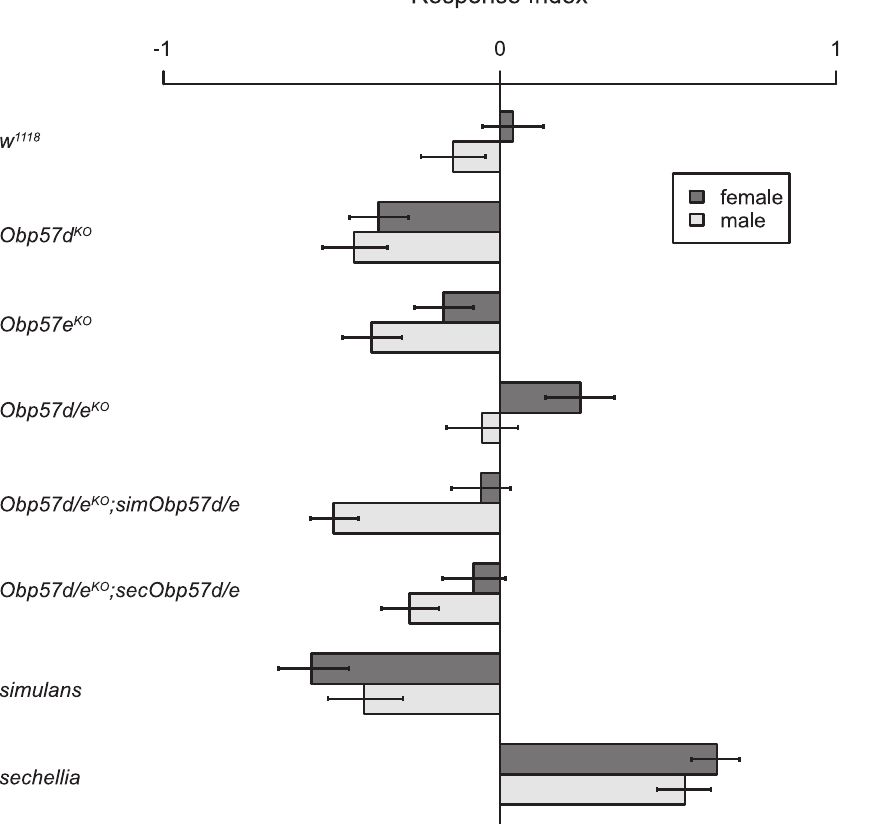
Figure 5. Olfactory Response of Obp57d/e Knock-Out Strains to HA in the Trap Assay Response index (RI) ¼ (N h (cid:2) N w ) / (N h þ N w ), where N h is the number of individuals trapped in 1% HA solution, and N w is that of individuals trapped in distilled water. At least 300 individuals were tested in five replications of the assay. Error bars indicate 95% confidence intervals determined by the binominal test.